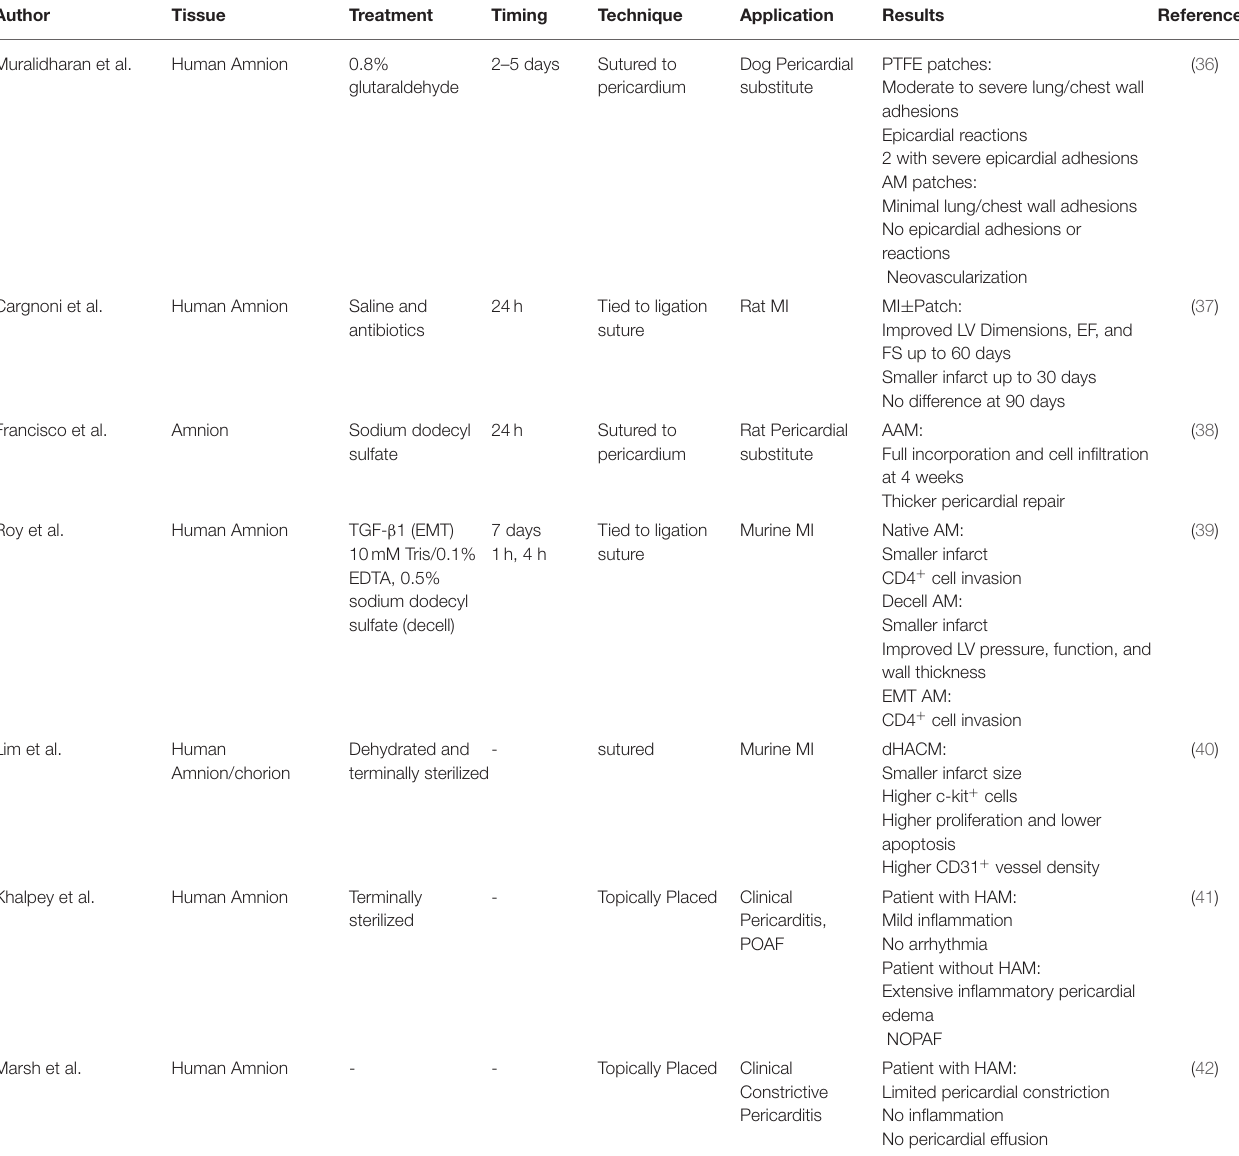
TABLE 1 | Summary of pre-clinical and clinical studies of placental tissue in cardiac